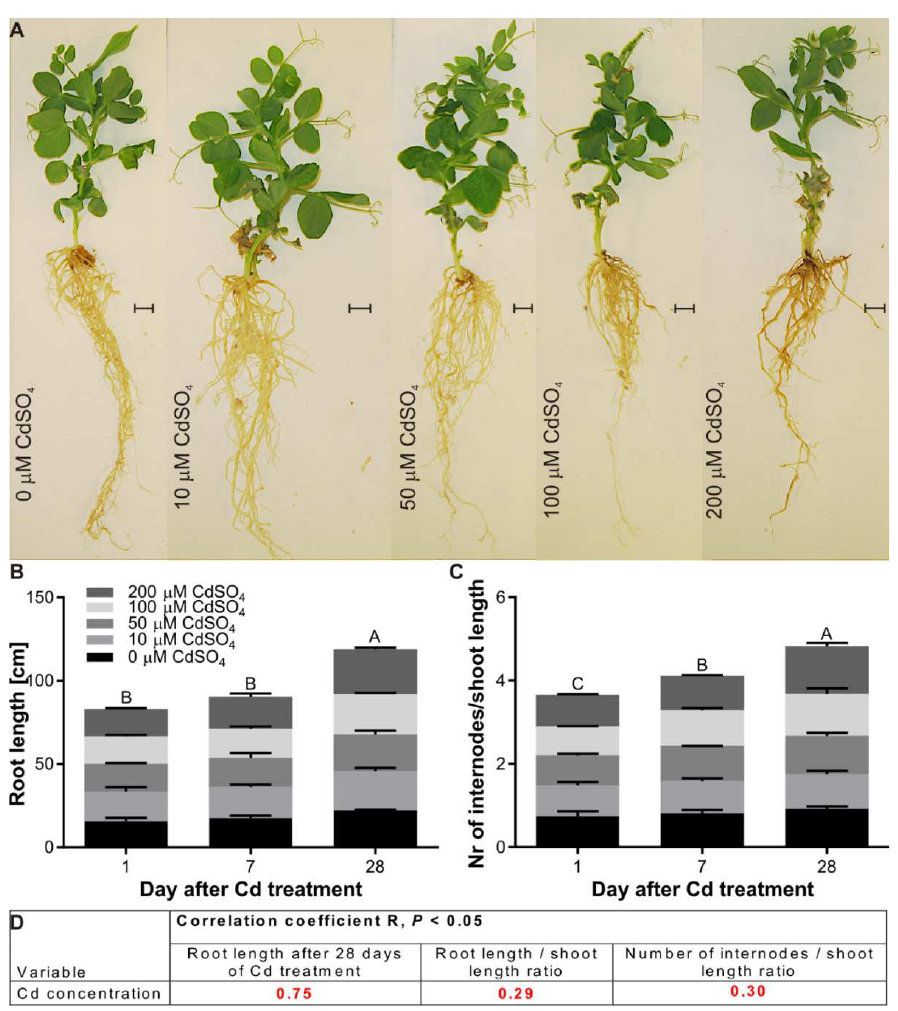
Figure 3. The growth of P. sativum L. during the experiment and after Cd-treatment. ( A )—Representative images of P. sativum L. 28 days after Cd-treatment. The picture shows the control plant (0 µ M CdSO 4 ) and the plant treated with 10, 50, 100 and 200 µ M CdSO 4 . Scale bar: 1 cm. ( B , C )—The root length ( B ) and the ratio of the number of internodes to shoot length ( C ) changes during the experiment. Each value is the mean of three replicates ± SD. Different letters represent significant differences ( p < 0.01). ( D ). The statistically significant results of the correlation analysis are presented as Pearson’s correlation coefficients (R).